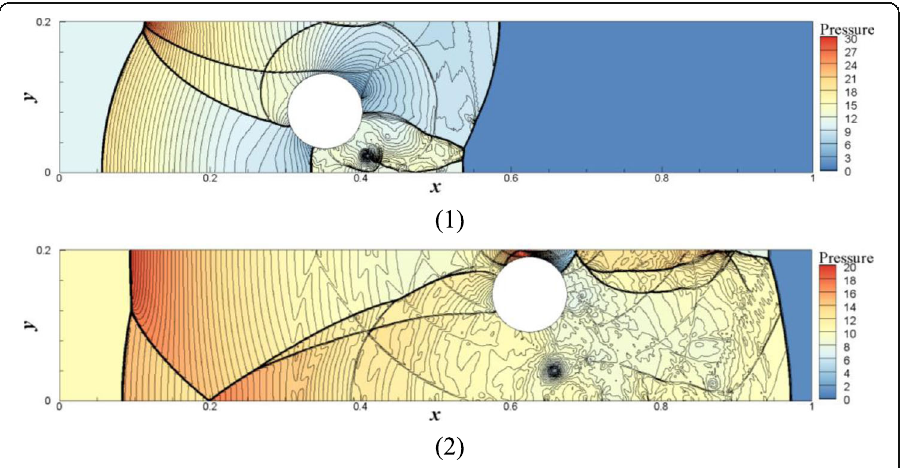
Fig. 12 Present pressure contours ( Δ h = 1/2000 m ) at different time: (1) t = 0.1641 s , and (2) t = 0.30085 s